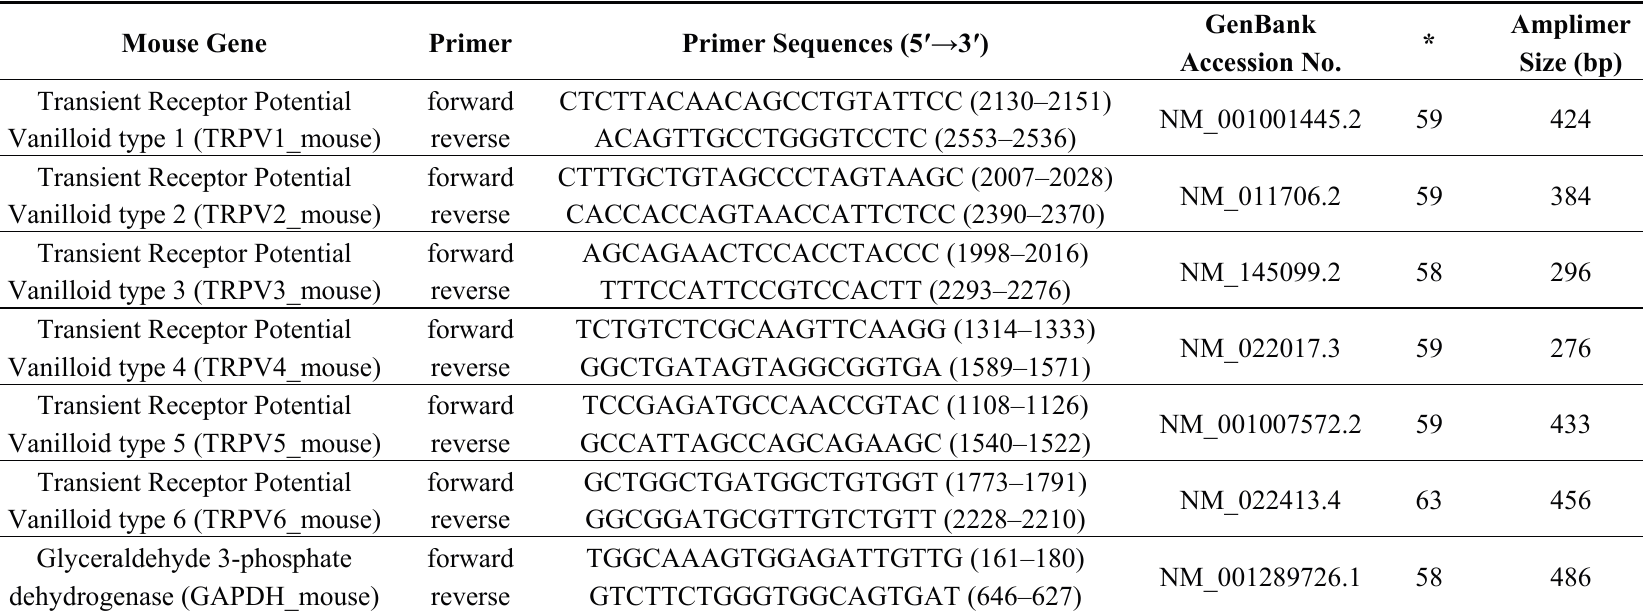
Table 2. Nucleotide sequences, amplification sites, GenBank accession numbers, amplimer sizes and PCR reaction conditions for each mouse primer pair are shown. * annealing temperature